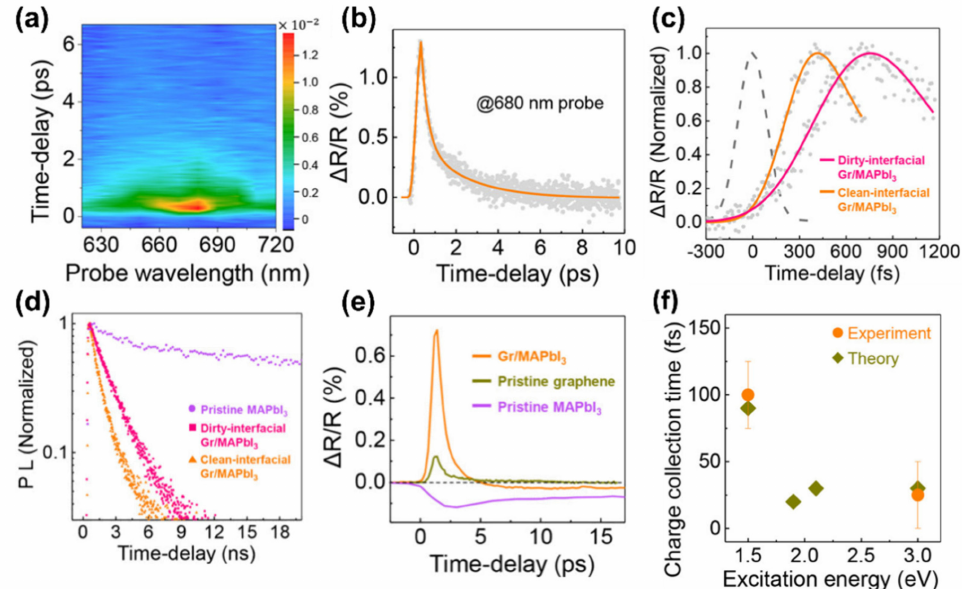
Figure 3. ( a ) Pseudo-colour transient absorption plot of clean graphene/MAPbI 3 interface at different probe wavelength and with pump wavelength of 820 nm. ( b ) Differential reflection measured from the clean graphene MAPbI 3 heterostructure with 680 nm probe pulse. ( c ) Normalized differential reflection measured from both dirty- and clean-graphene/MAPbI 3 interface. The dashed line is the laser cross-correlation function used for the deconvolution of the rising part of the transient absorption signal. ( d ) Normalized time resolved photoluminescence spectroscopy measurements performed on pristine MAPbI 3 and on clean and dirty graphene/MAPbI 3 interfaces. ( e ) Differential reflection measured from the pristine MAPbI 3 , the pristine graphene and the clean graphene/MAPbI 3 interface. ( f ) Comparison of the theoretical time-dependent density function calculations and experimental results of charge collection time of the carriers. Data taken from ref. [65]. Copyright